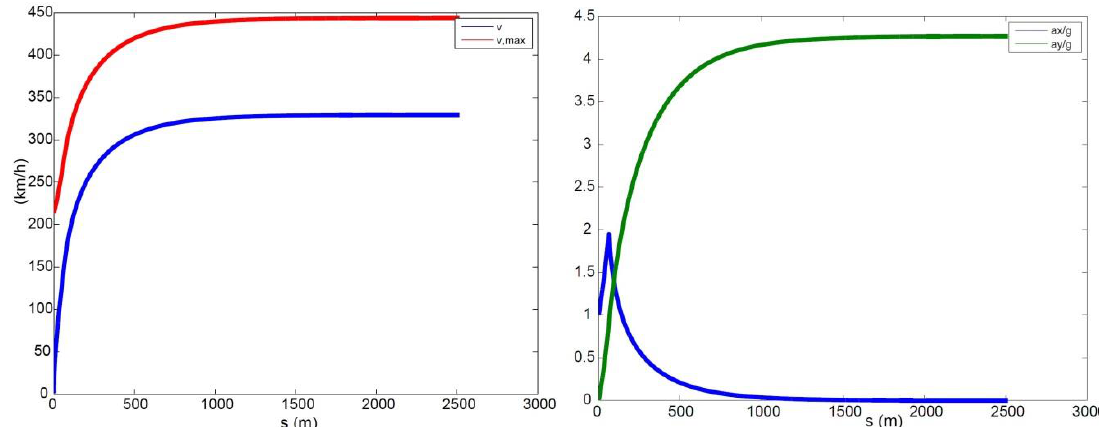
Figure 7. Circumference, aerodynamics, R = 200 m: (left) speed and (right) accelerations with respect to s .